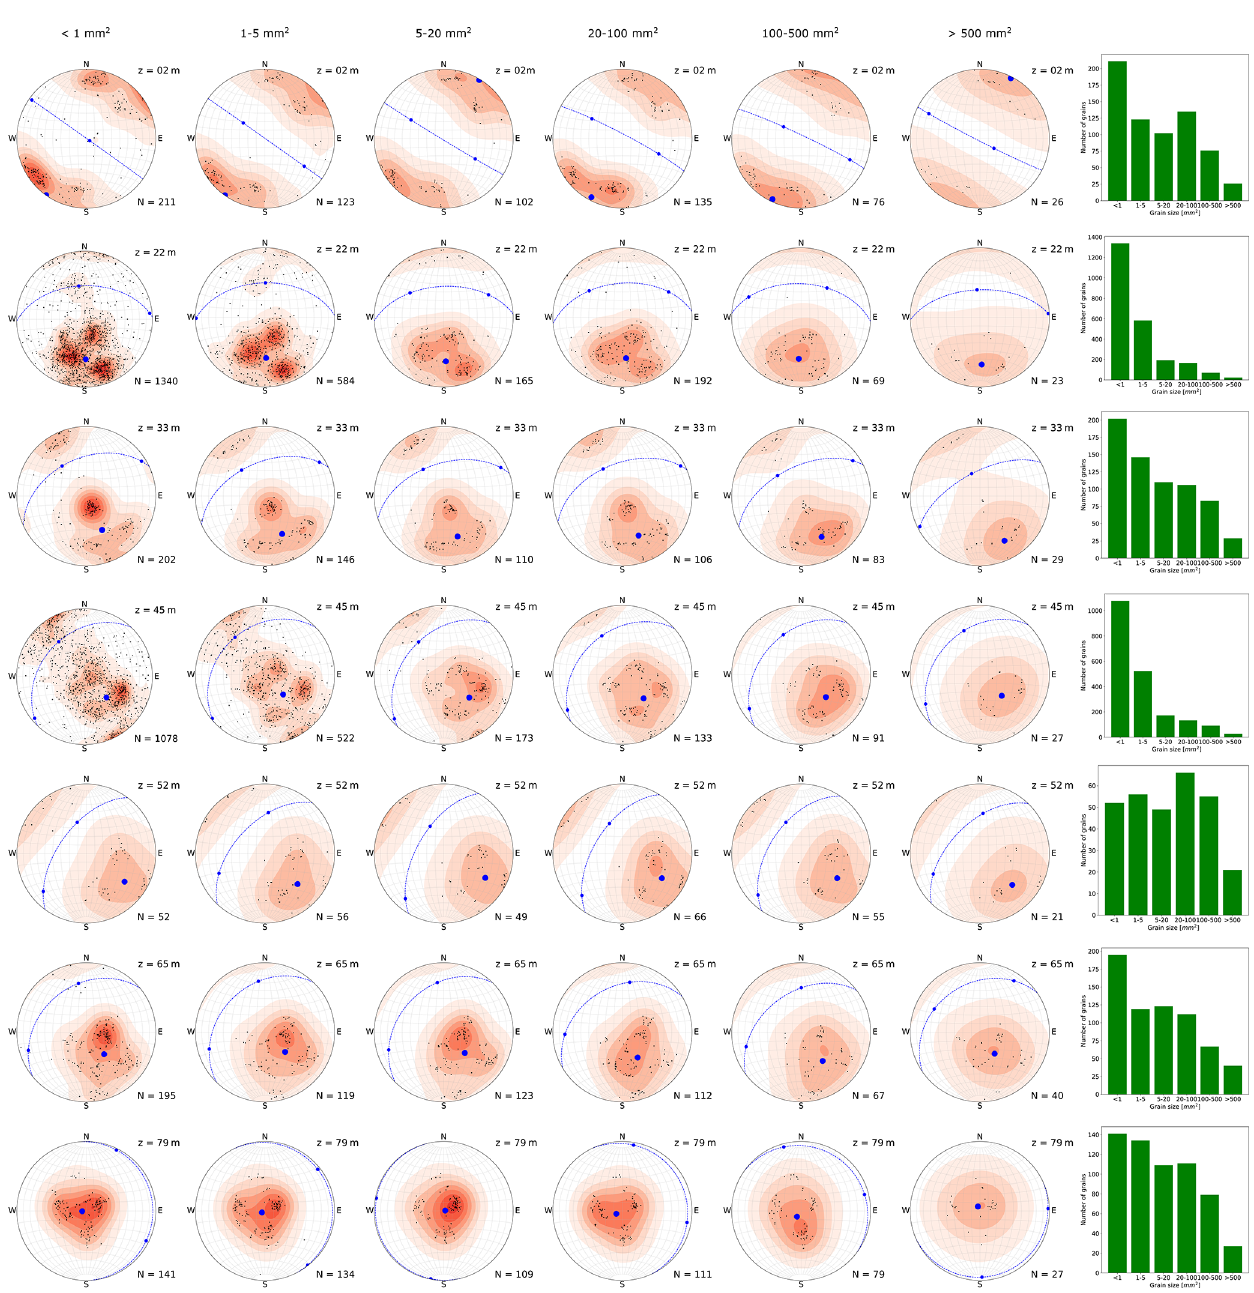
Figure A1. Stereo-plots (lower-hemisphere Schmidt equal-area projection) with the colour coding the same as in Fig. 5. Each column represents a grain size class as indicated at the top. Each line represents one of the seven samples of Fig. 5. The number of grains per class is specified for each plot. The largest calculated eigenvector for the c -axis distribution is shown as a blue dot (its normal plane as a dashed blue line). Last column: histograms showing the number of grains per class for each